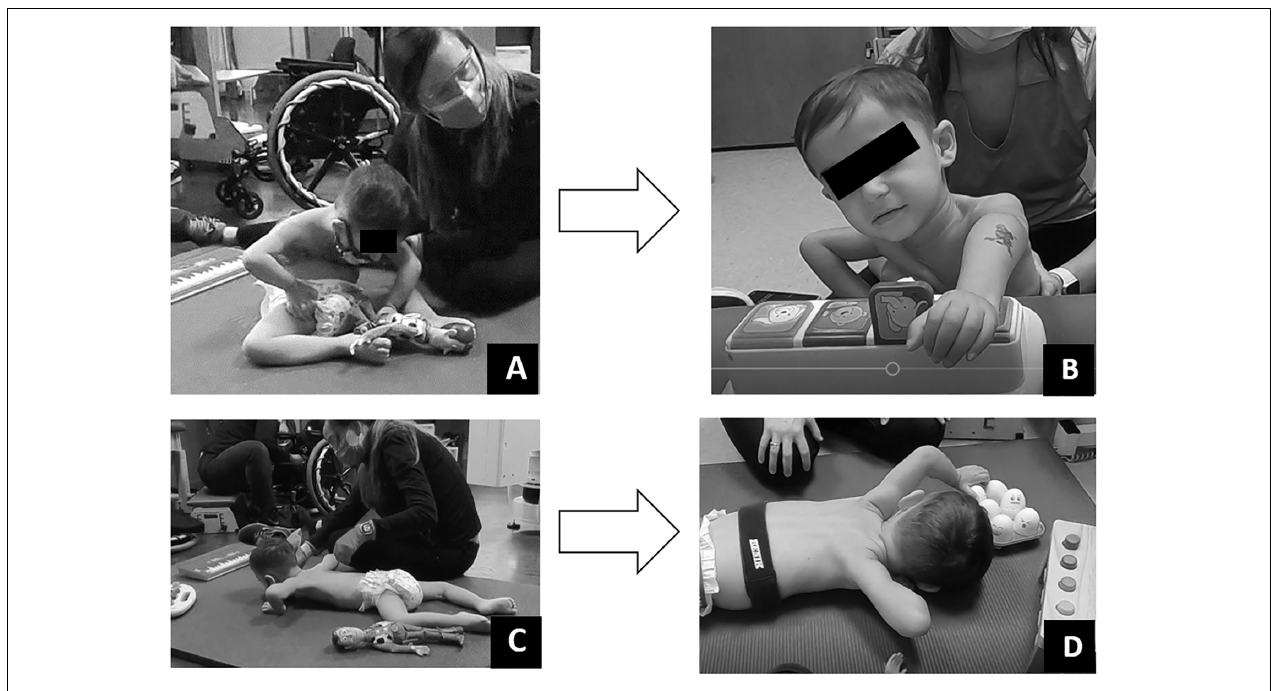
FIGURE 6 | Play assessment. (A) Initial evaluation in supported sitting child could minimally touch toy but was unable to manipulate. (B) Discharge evaluation in supported sitting child could touch and manipulate toys within his reach. (C) Initial evaluation in prone child could not move arms forward to reach and engage. (D) Discharge evaluation in prone, child able to reach forward to engage and manipulate toys within his